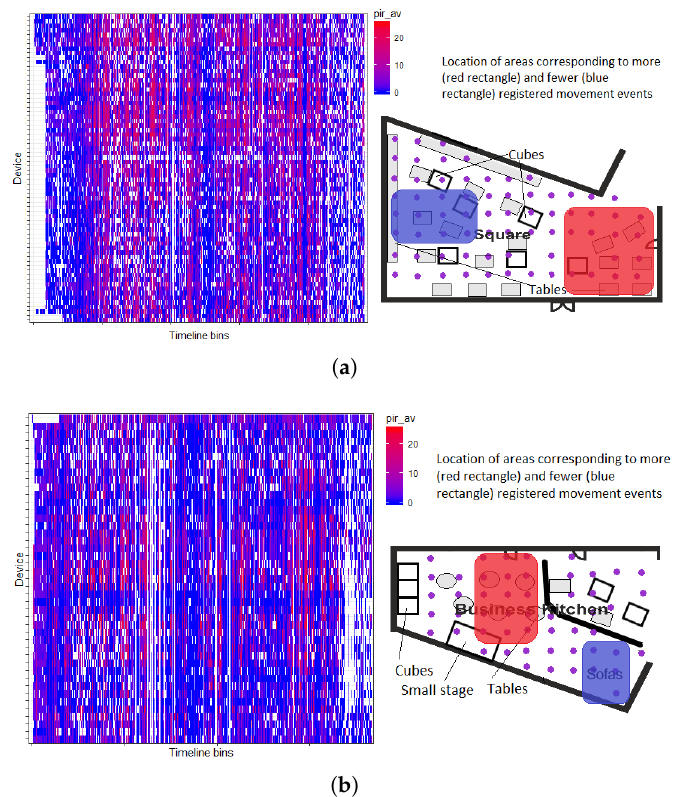
Figure 10. Average pir readings in Square ( a ) and Business Kitchen ( b ) areas over ordered 15-min time